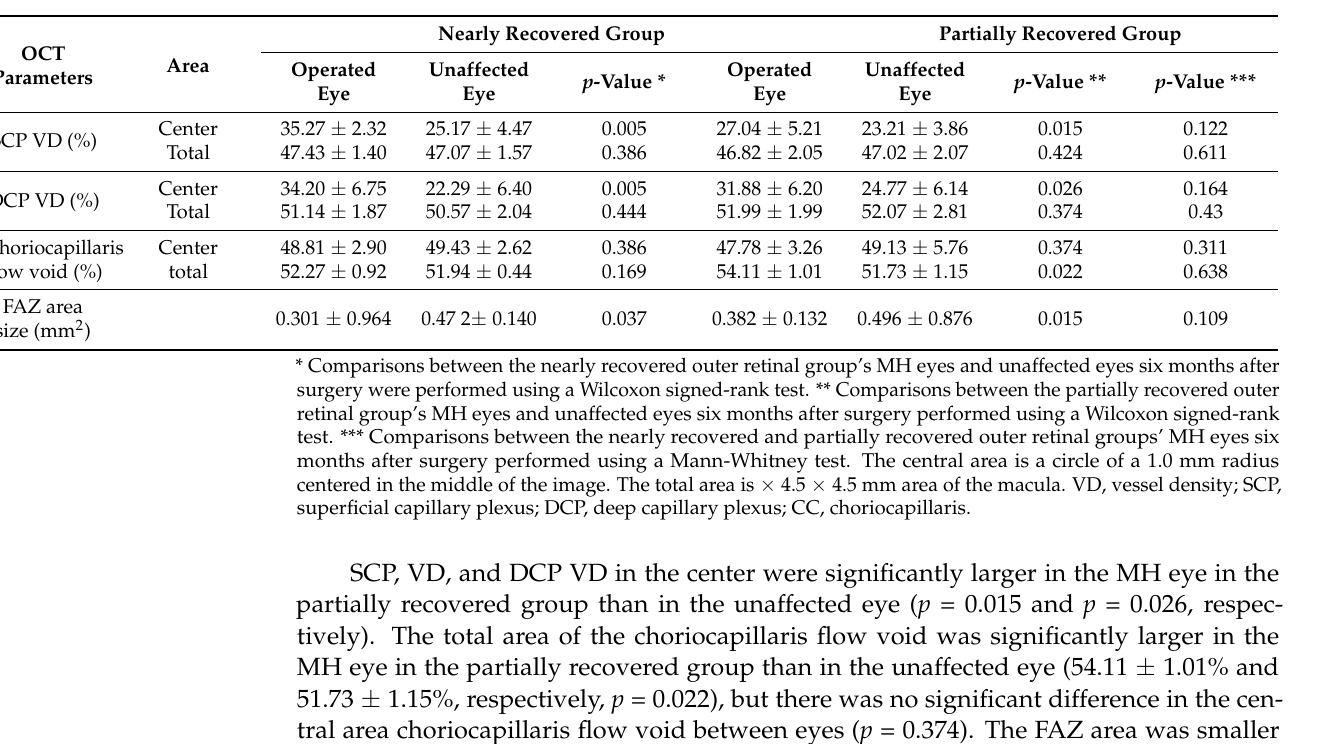
Table 4. Comparison between the vessel density of eyes with full thickness macular hole six-months postoperatively and unaffected